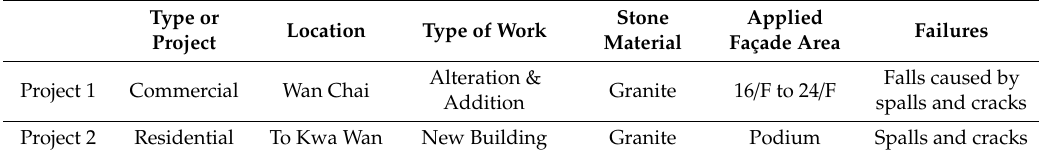
Table 1. Information on two projects selected for case